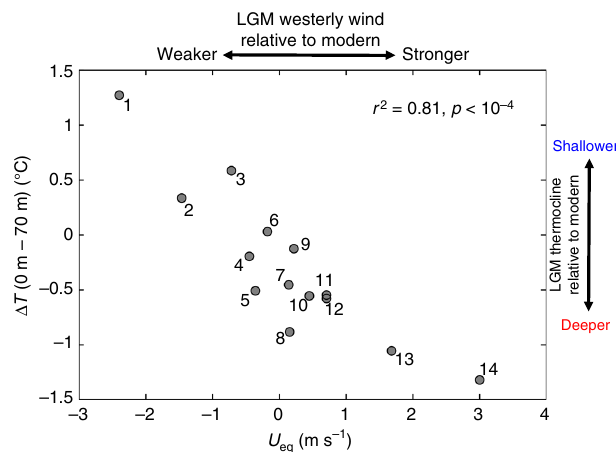
Fig. 4 LGM thermocline depth anomaly in the eastern Indian Ocean vs. equatorial Indian Ocean zonal wind anomaly as simulated in PMIP2 and PMIP3/CMIP5 models. Δ T is used as a measure for thermocline depth and de fi ned as the annual mean temperature difference between surface and 70 m averaged over the eastern Indian Ocean region 4° N – 6° S, 94° E – 104° E. U eq is de fi ned as the annual mean zonal low-level (925 hPa) wind averaged over 5° N – 5° S, 50° E – 100° E (Fig. 5). Shown are LGM anomalies relative to pre-industrial control runs for both quantities. The models are numbered as in Supplementary Table 2. Models with strongest LGM thermocline deepening and westerly wind anomalies are CCSM3 (No. 13) and FGOALS-g1.0 (No.